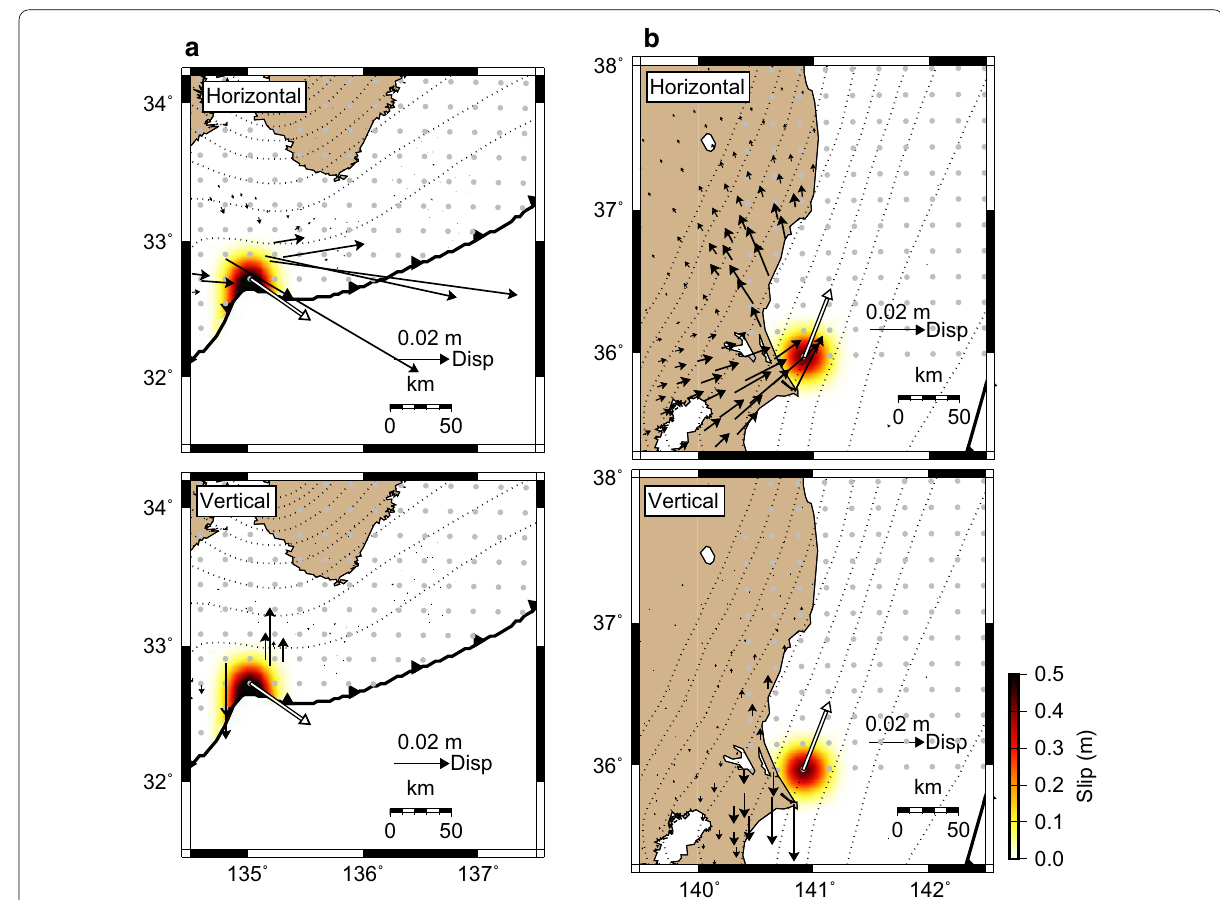
Fig. 5 Examples of GF calculated based on FE modeling. a A unit slip and its response displacement in the direction opposite to the plate convergence in Nankai Trough and b one in the direction perpendicular to the plate convergence in the Japan Trench subduction zone. Note that unit slip in the location beyond the trench or trough axis is set forcibly zero in a . Gray dots denote the central point of B-spline function shaped slip applied in a subfault. The color map shows slip distribution. The black arrows denote the horizontal (top) and vertical (bottom) surface displacements due to the fault slip. The white arrows denote fault slip